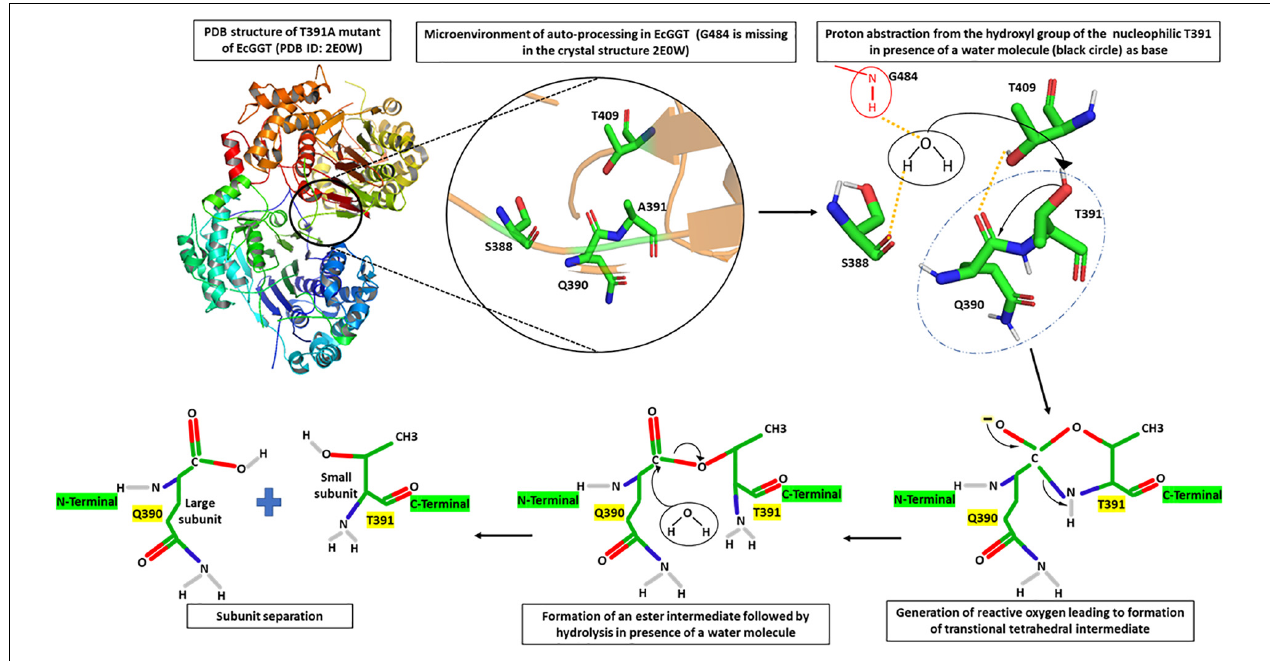
FIGURE 2 | Microenvironment for autocatalytic processing of Escherichia coli gamma-glutamyl transpeptidase (EcGGT) and its detailed molecular mechanism. Crystal structure of T391A precursor mutant of EcGGT (PDB ID: 2E0W) has been used for studying autocatalytic environment. A391 in the structure has been replaced by T391 to show hydrogen bonding (yellow dashed lines) and nucleophilic attack (black arrow) by T391 during autoprocessing. A water molecule (black circle) and amide bond of G484 (red circle) have been drawn to show bonding. The structures are prepared using PyMOL2 software.